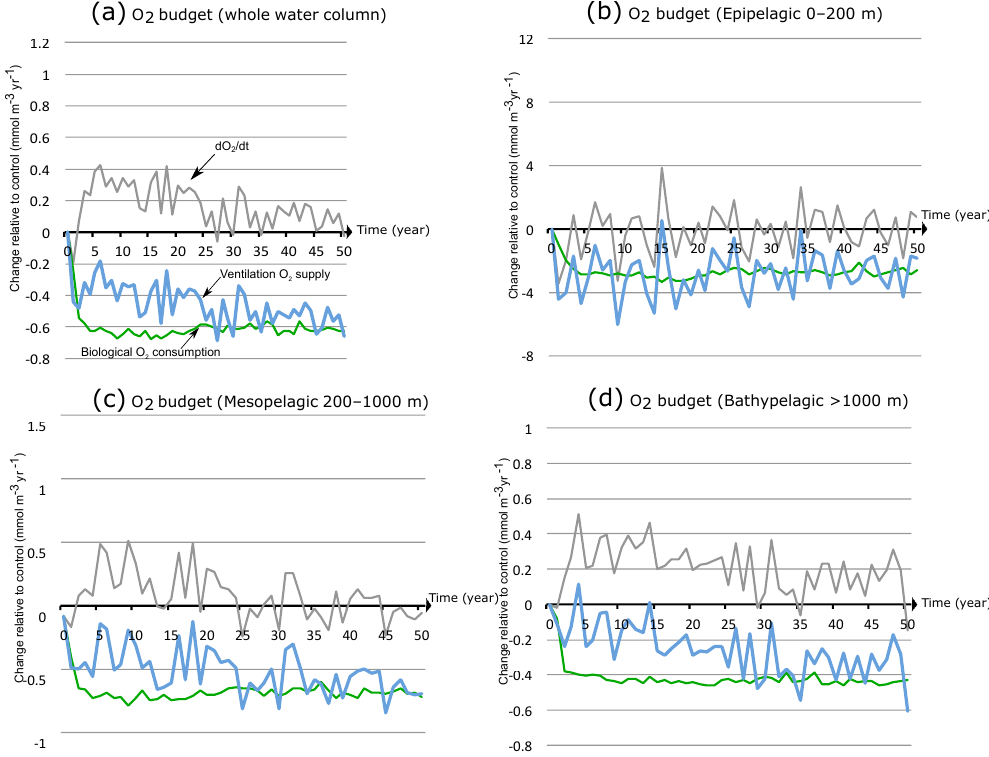
Figure A9. Drivers of OMZ contraction under monsoon weakening. Annual O 2 accumulation (tendency dO 2 ( − 50%) relative to control (grey line) and its biological (green) and physical (blue) sources in the OMZ as a function of time in (a) the whole water column, (b) the epipelagic zone (0–200m), (c) the mesopelagic zone (200–1000m) and (d) the bathypelagic zone ( >